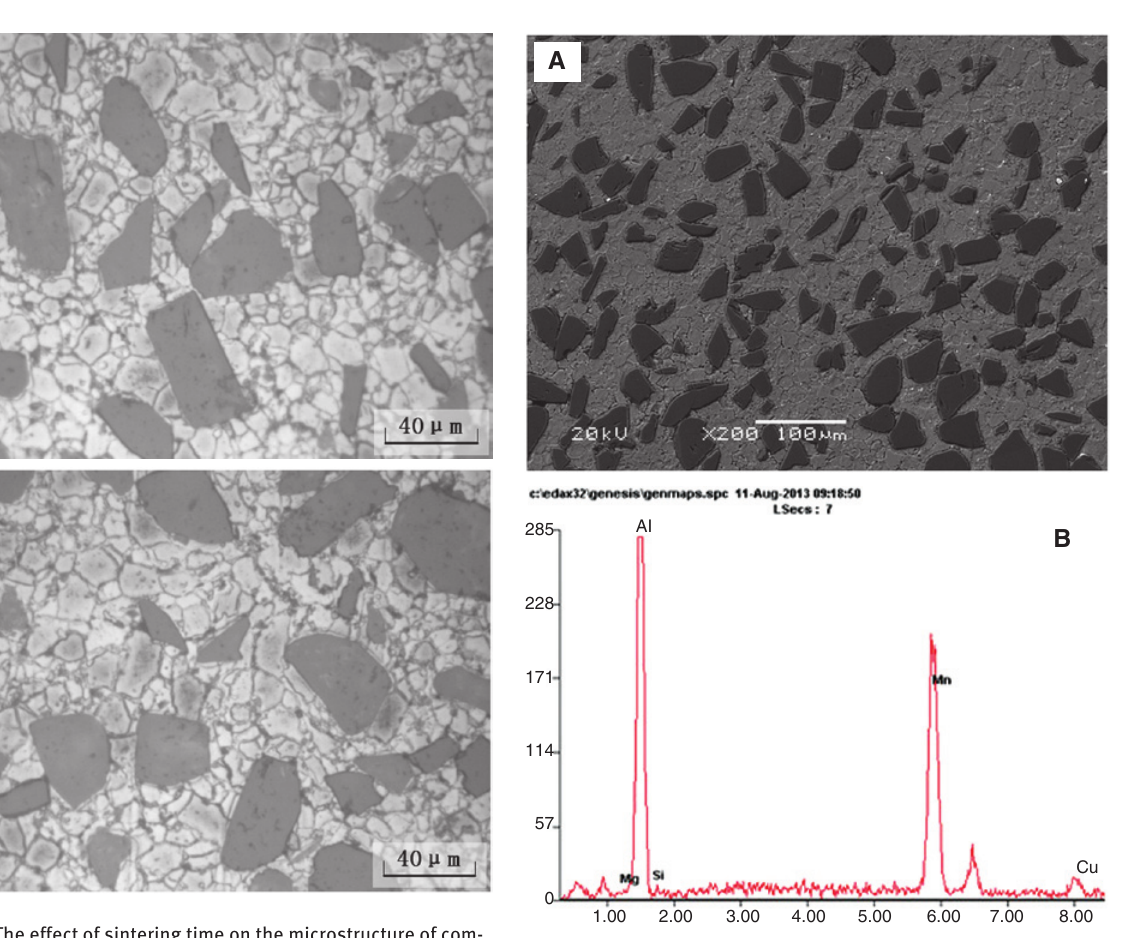
Figure 9 The effect of sintering time on the microstructure of com- posite (A) 3 h (B) 4 h. Figure 11 The SEM micrographs of the composite samples made at 580 ° C in solution treatment conditions (A) SEM (BSE) images, showing few precipitates present in the matrix and at interfaces; (B) EDS spectrum of a precipitate shown in Figure 11A.